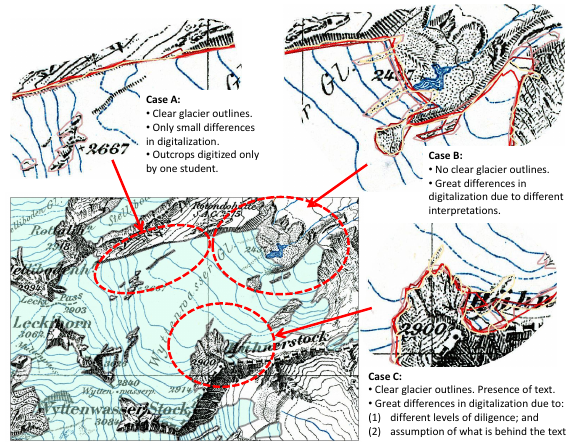
Figure 5. Examples of conflicts encountered during digitization of historical maps. The map shows the glacier area digitized for the end product (blue area with black outlines) and in the background the sheet of the Siegfried map for the publication year 1934 for the Wyttenwasser glacier. In cases A to C the outlines of the same glacier area digitized by five students are shown (coloured